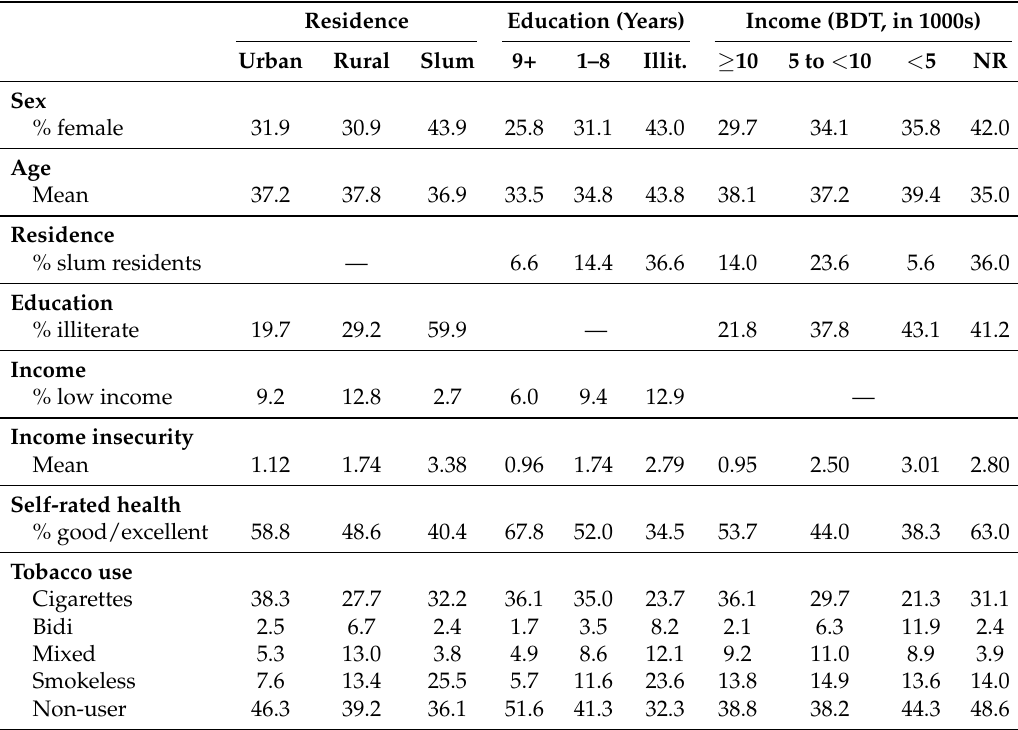
Table 2. Characteristics of vulnerable groups in